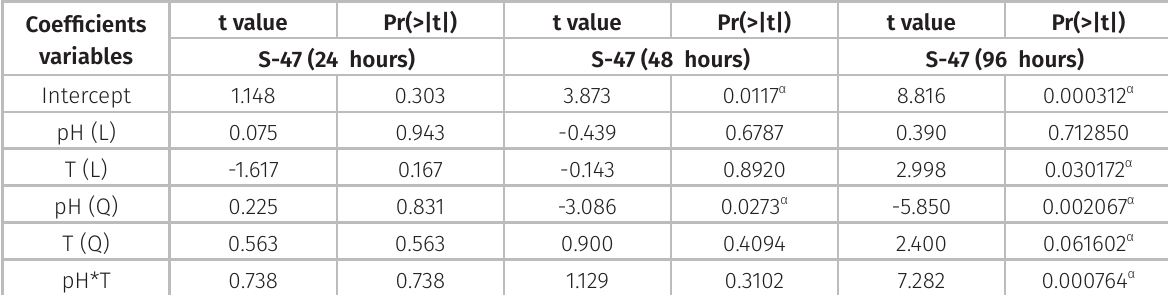
Table III. Main effect (t-value) and p-value of pH and temperature for S-47 Candida homilentoma , using CCRD.